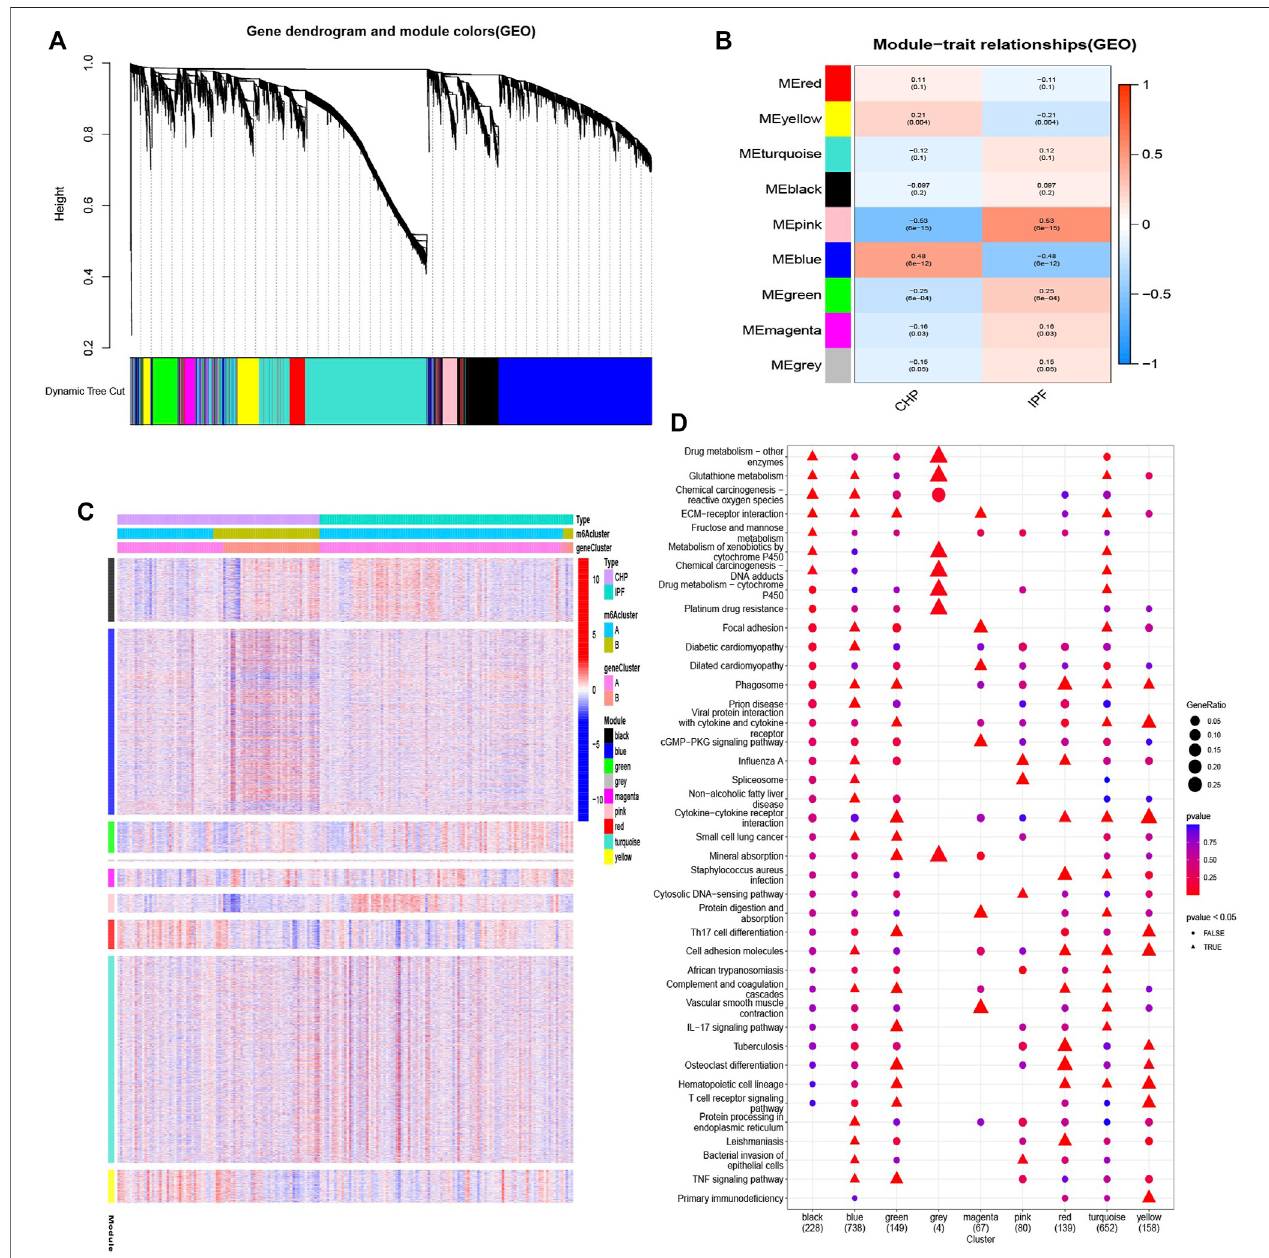
FIGURE 9 | Biological characteristics of different patterns (A,B) Gene-gene modules related to different samples were identi fi ed by WGCNA. (C) Unsupervised clustering of overlapping m6A phenotype-related genes to classify patients into different clinical subtypes, termed as CHP and IPF, respectively. The gene clusters, m6Aclusters, and clinical subtypes were used as patient annotations. (D) Pathway annotations for each module using KEGG analysis. The color depth and graphic shape of the bubble represented the number of genes enriched. △ p < 0.05.